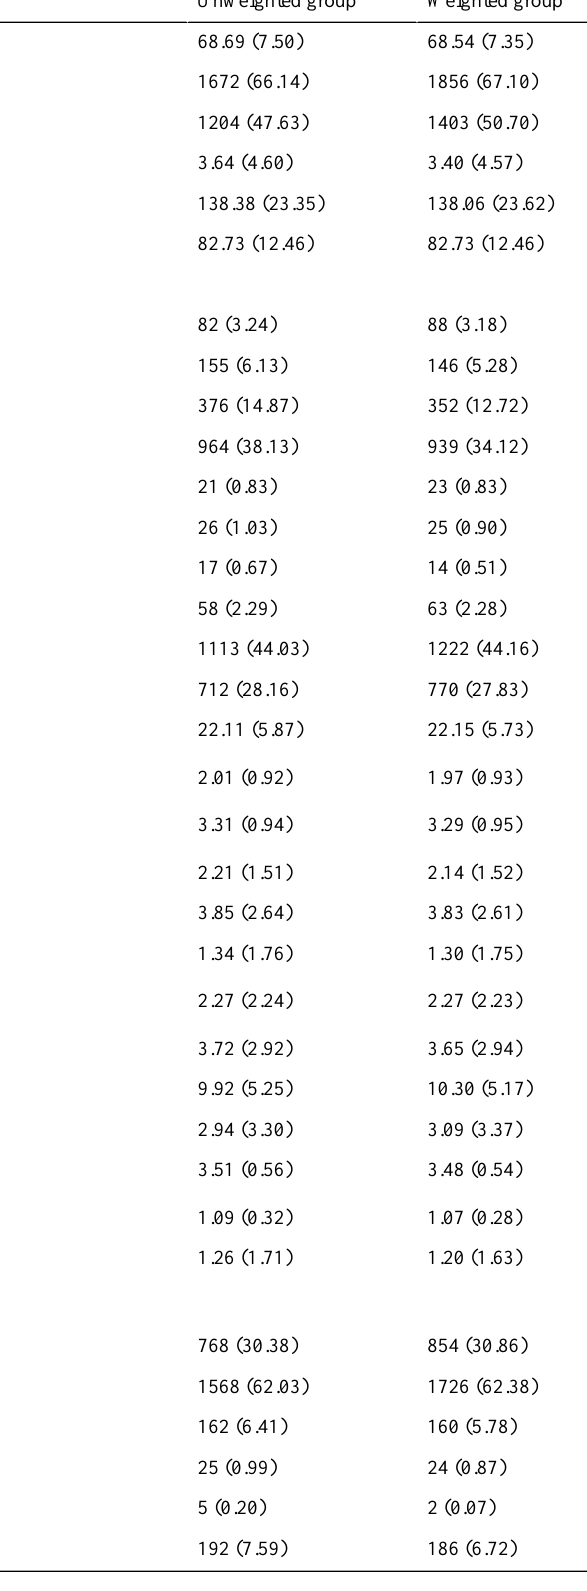
Weighted groupUnweighted